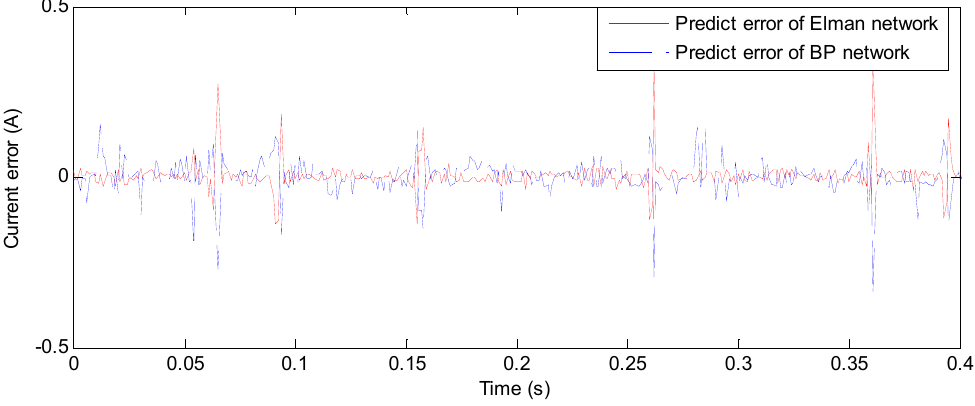
Figure 12. Current errors using the Elman and BP networks.